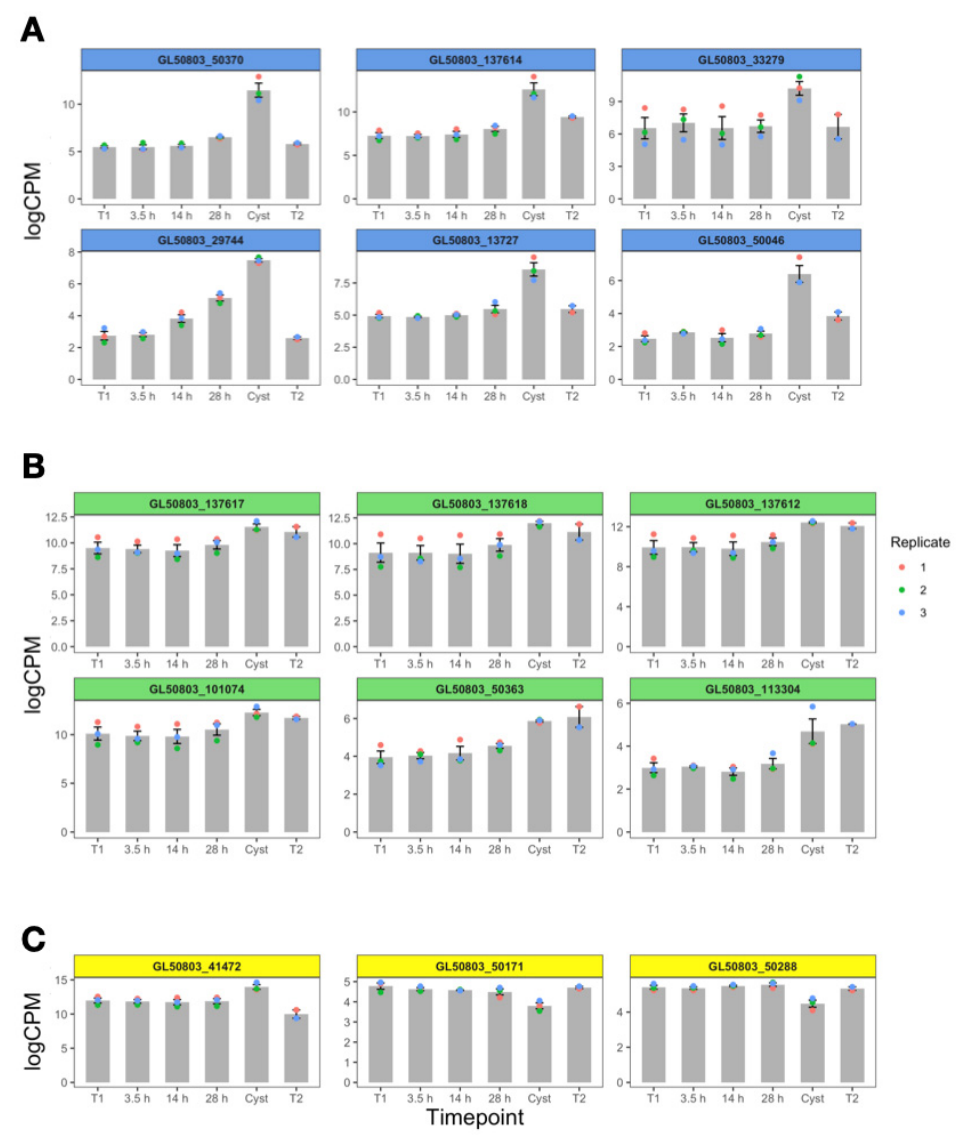
Figure 6. VSP expression during selected timepoints of encystation as CPM values. Red dot, replicate 1; green dot, replicate 2; blue dot, replicate 3. CPM values are in log2 space. The genes were assigned into three different groups with similar behavior during encystation: ( A ) Genes with a blue header were found to be most upregulated in the cyst when compared to T1 and reversed to T1 levels in T2; ( B ) Genes with a green header were up-regulated in both cyst and T2 when compared to T1; ( C ) Genes with a yellow header where down-regulated in T2 and/or cyst when compared to T1.